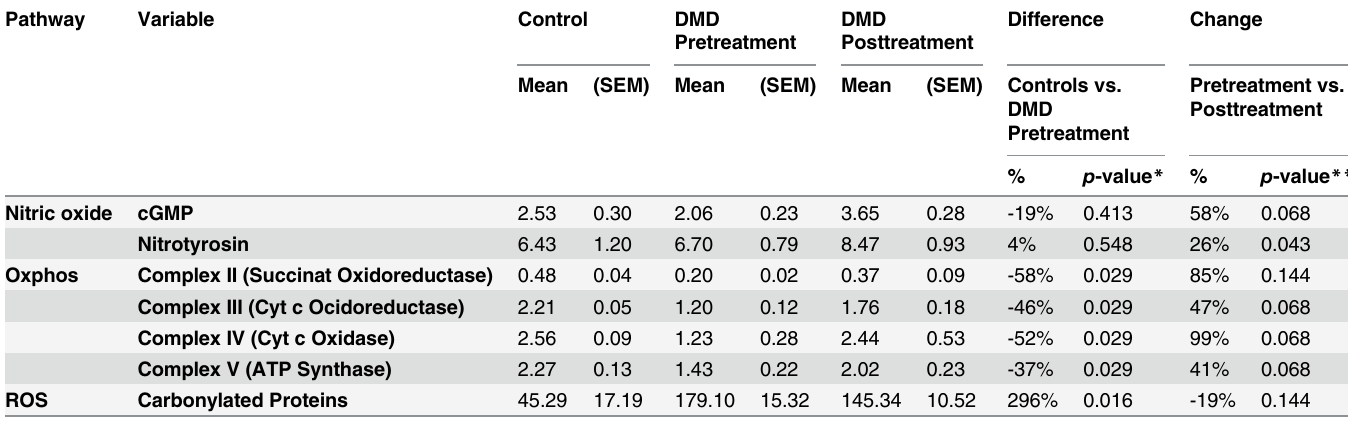
Table 2. Muscle biopsy analysis.